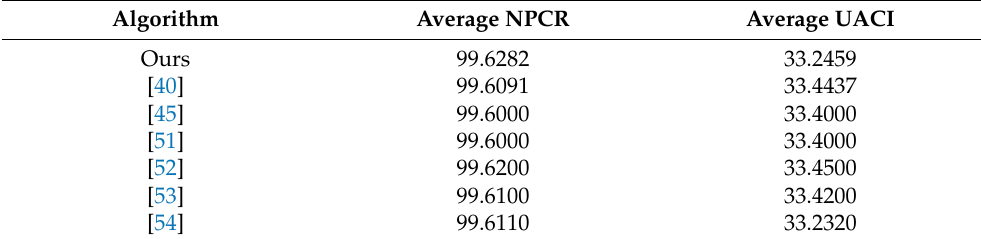
Table 5. The calculated average values of NPCR and UACI of our proposed scheme and its results comparisons with other existing encryption